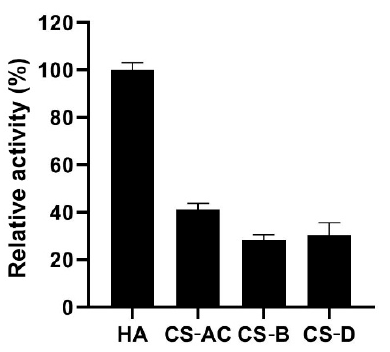
Figure 4. Substrate specificity of YsHyl8A. The activity of YsHyl8A towards HA was defined as 100%. Error bars indicate the standard deviation ( n = 3).